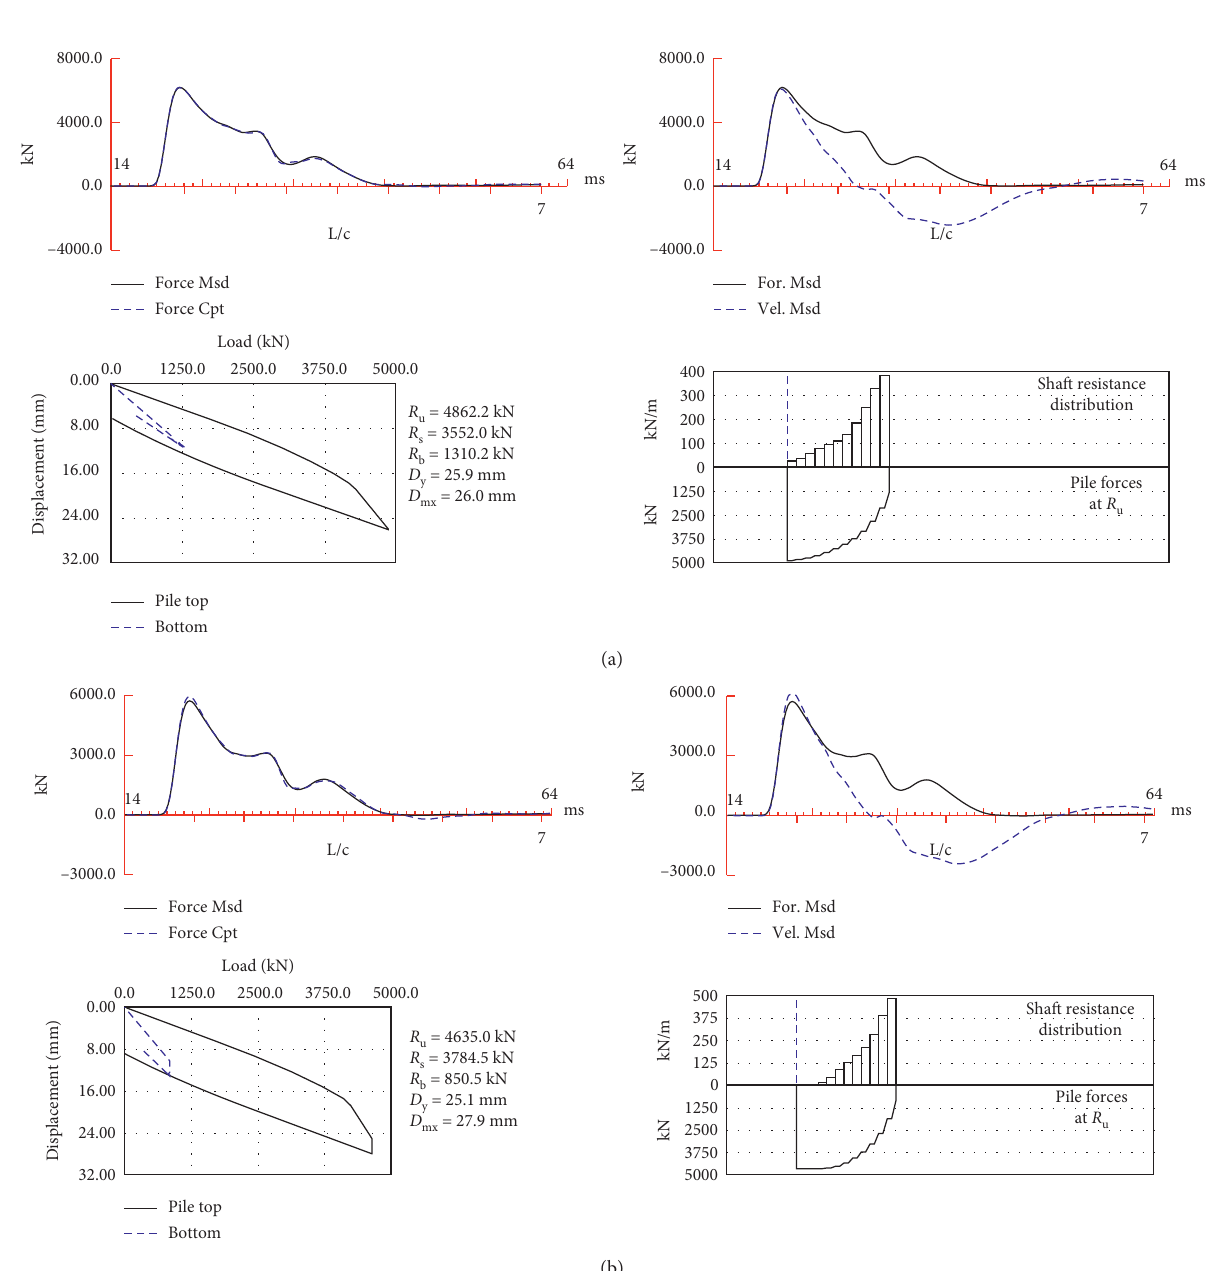
Table 10: Distribution ratio of pile side resistance to pile end resistance (at the hard rock bearing stratum site). Parameter Sliding micrometer test (SLT) HSDT Pile no. Total resistance (kN) Pile side resistance (kN) Pile end resistance (kN) Ratio of pile end resistance to total